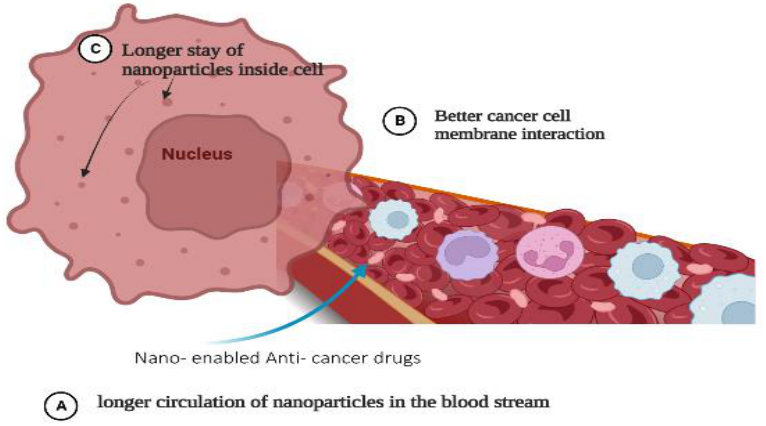
Figure 2. Entry and movement of nano-enabled anticancer drugs in a cancer cell.